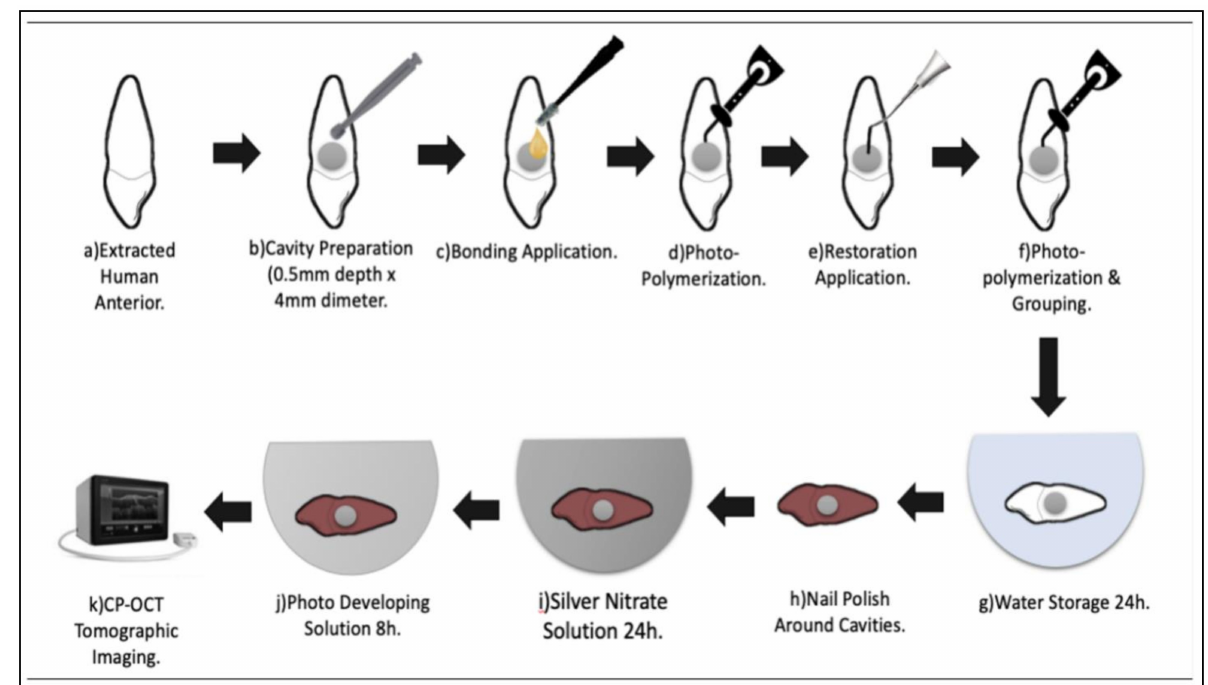
Figure 1. Schematic illustration of the specimen preparation, restoration, and CP-OCT imaging.